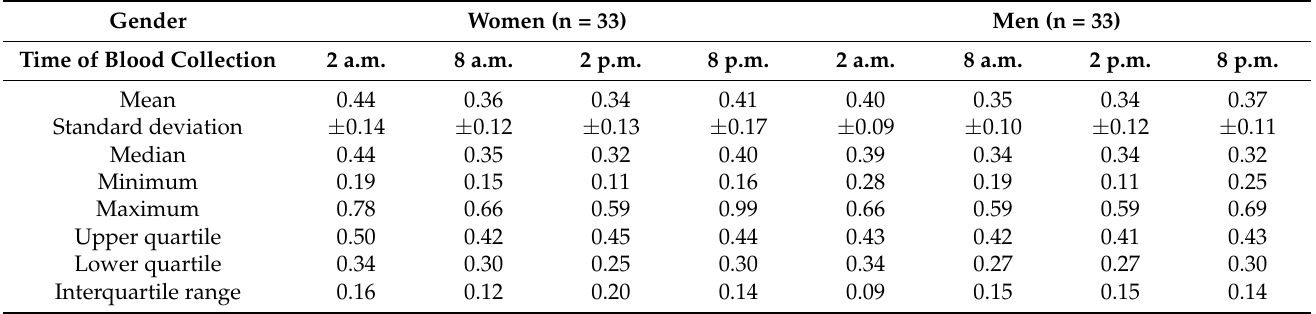
Figure 5. Average erythrocytes activity of R-GSSG in men and women at different sampling time points. Data presented as mean ± 95% confidence interval. MANOVA-type analysis ( p = 0.93669). Table 7. Parameters describing glutathione transferase (GST) activity in women and men, including the time of blood collection (U/g